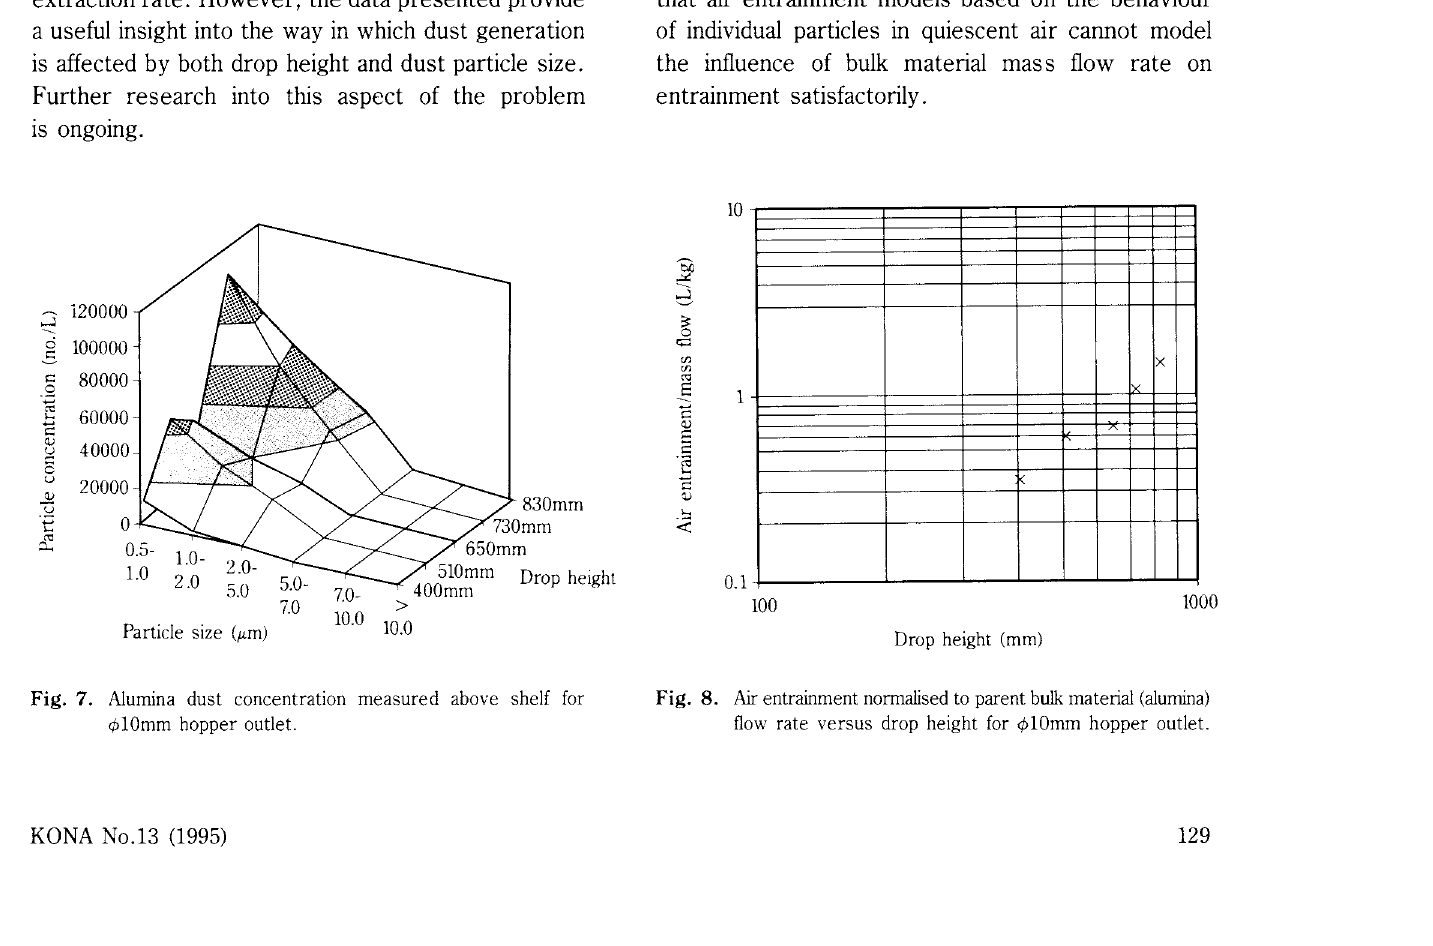
Fig. 7. Alumina dust concentration measured above shelf for <t>10mm hopper outlet.